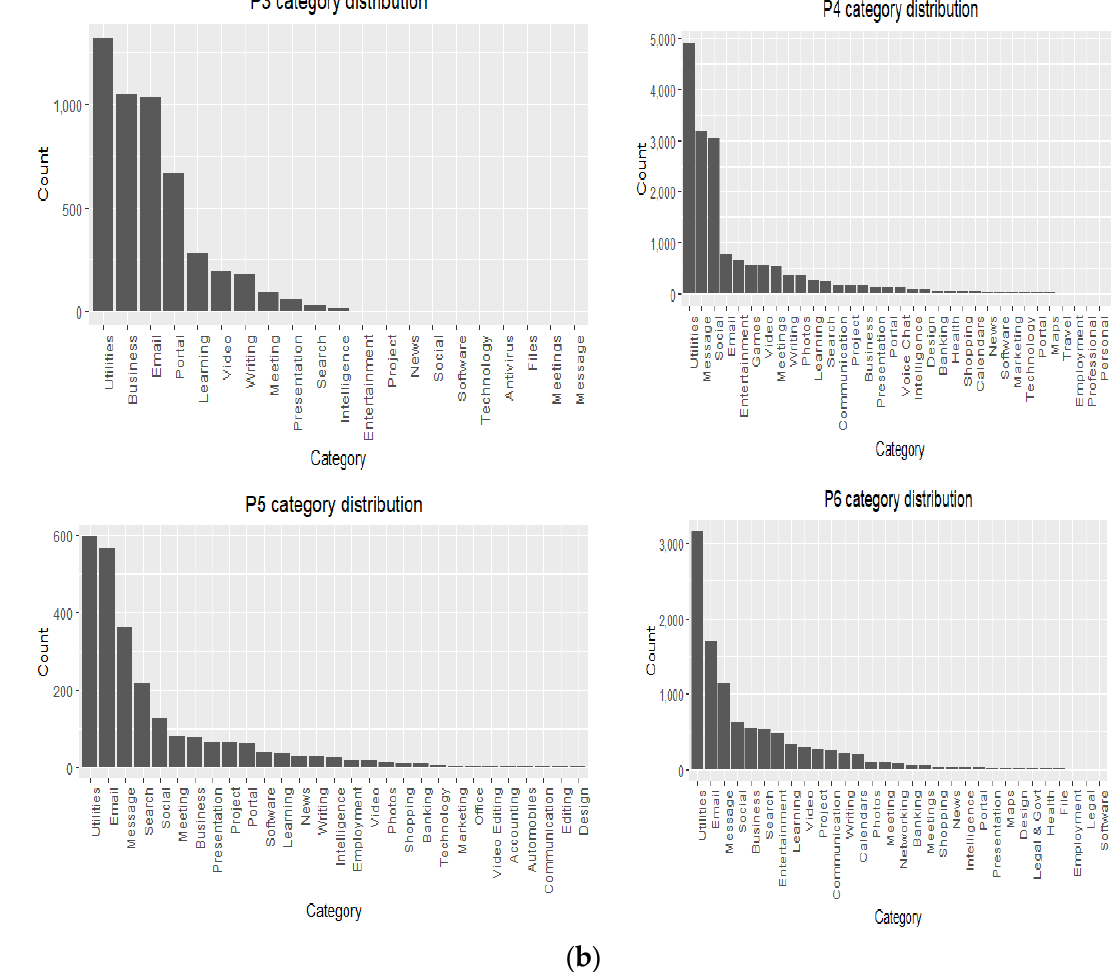
Figure 11. ( a ). Hourly Computer Usage per participant ( n = 6). ( b ). Work tab engagements.